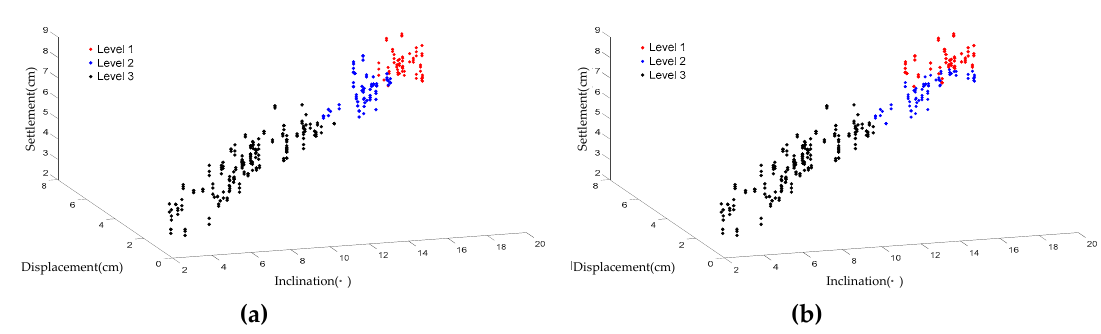
Figure 15. Two different predicted results of the damage level classification pattern ( ΙΙ ): ( a ) and ( b ) were two different predicted results in different simulation processes.